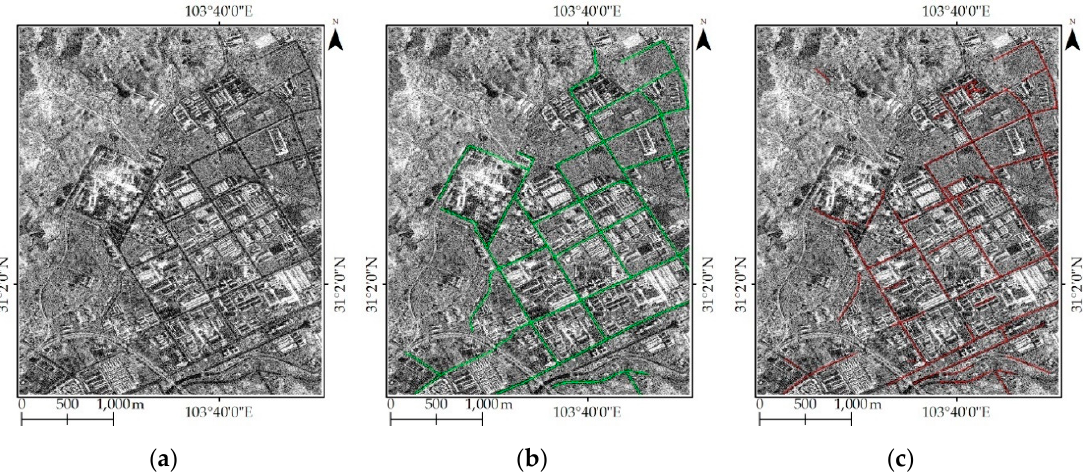
Figure 7. Road extraction results for study site 1. ( a ) Original SAR image; ( b ) reference road network; ( c ) extracted road network with proposed method.